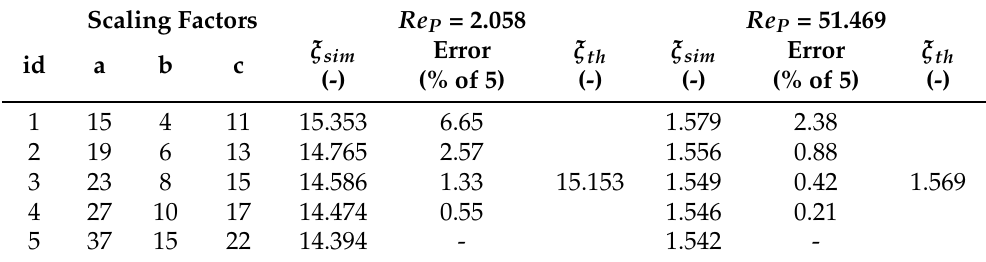
Table A3. Domain size study of reference particle cases.